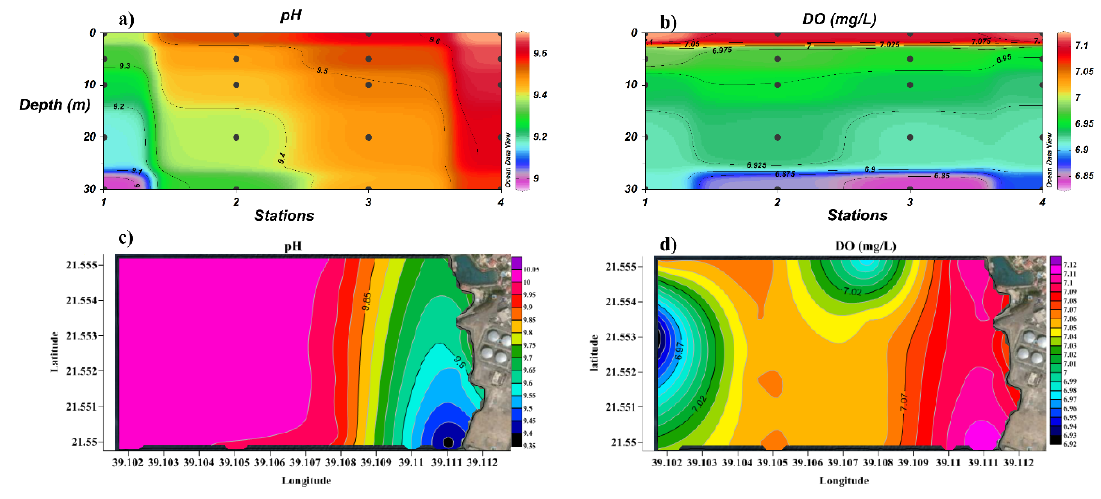
Figure 3: Surface distribution pattern of a) DO and b) pH; cross-section profile of c) pH and d) DO.